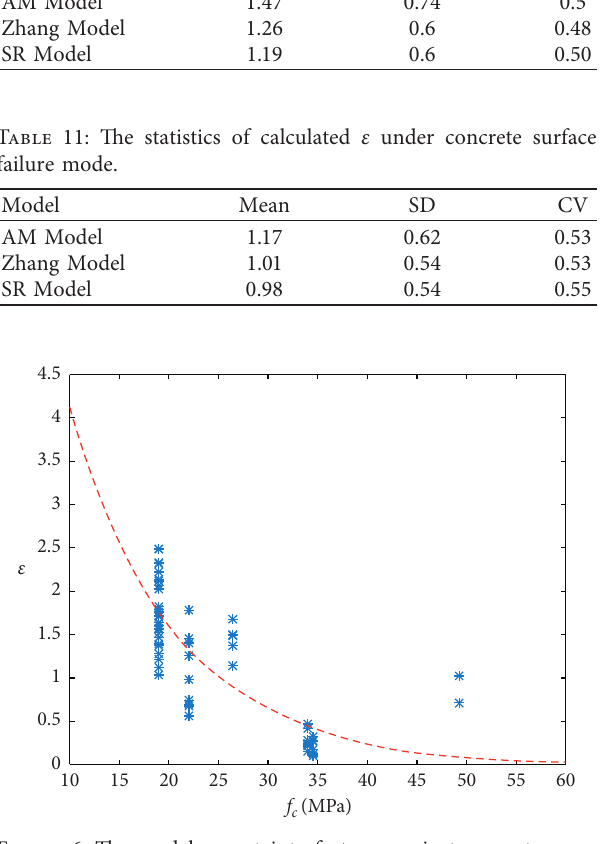
Figure 6: The model uncertainty factor ε against concrete com- pression strength f c (AM Model).